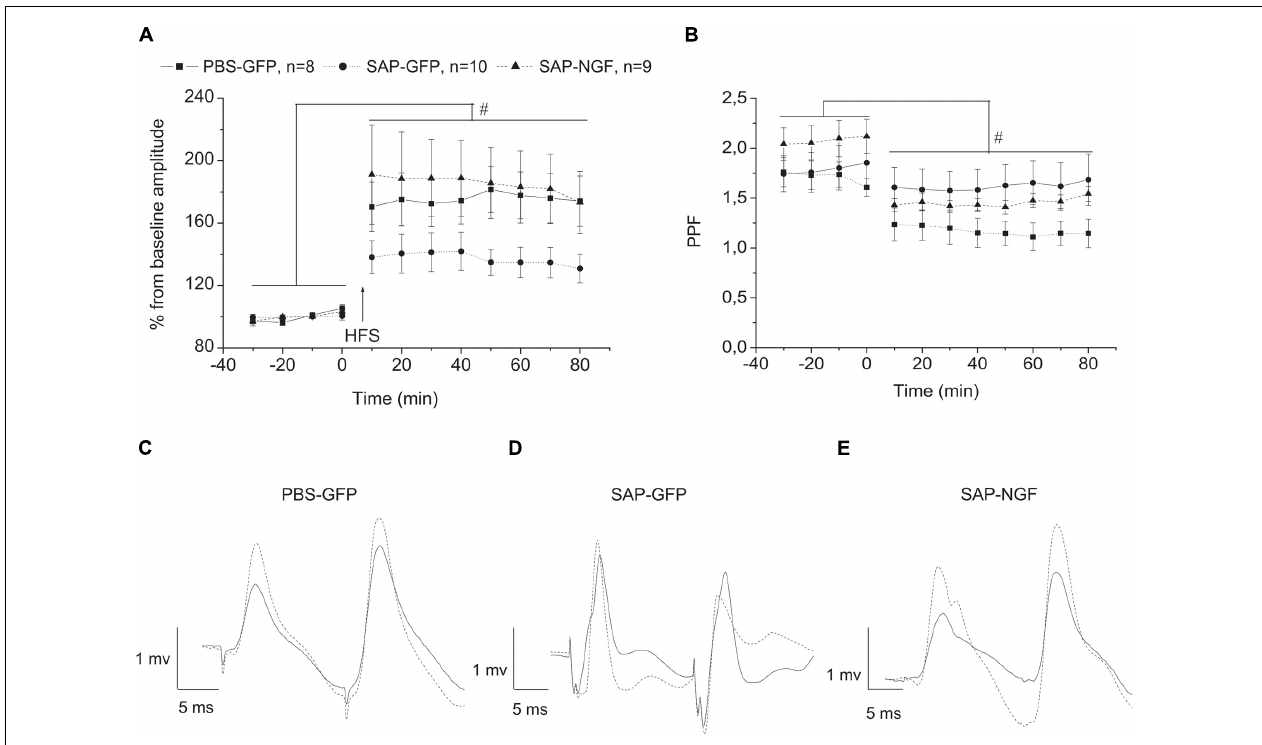
FIGURE 5 | (A) Shows that cholinergic deficit induced by 192IgG-saporin significantly suppressed LTP induction in VHC-CA1 pathway [SAP-GFP ( n = 10) and PBS-GFP groups ( n = 8)]. NGF overexpression (SAP-NGF group, n = 9) facilitates the induction of hippocampal LTP as compared with SAP-GFP group. In (B) ,